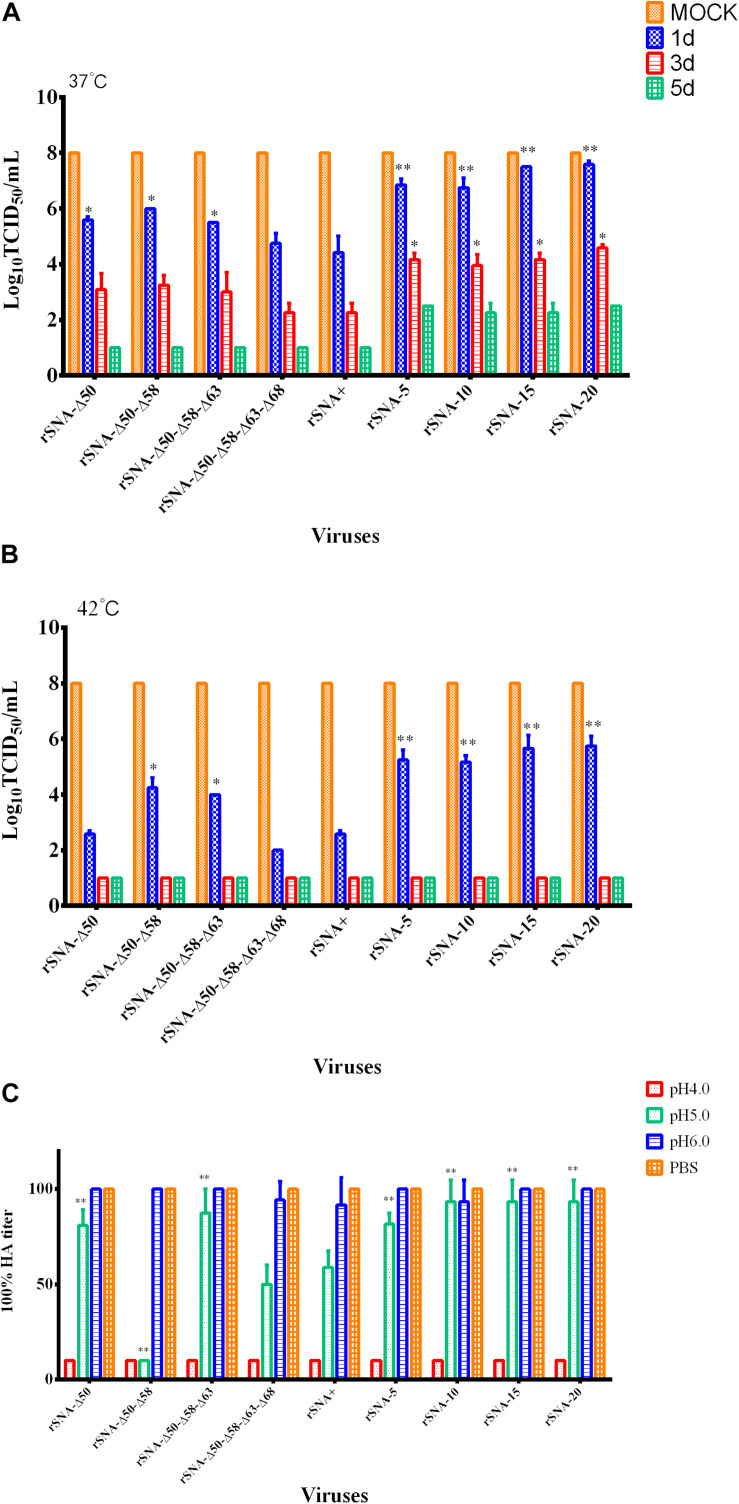
Thermal stability of the recombinant viruses at 37°C (A), 42°C (B), and low-pH stability of them (C). *P < 0.05, **P < 0.01, compared to the value of the rSNA+.